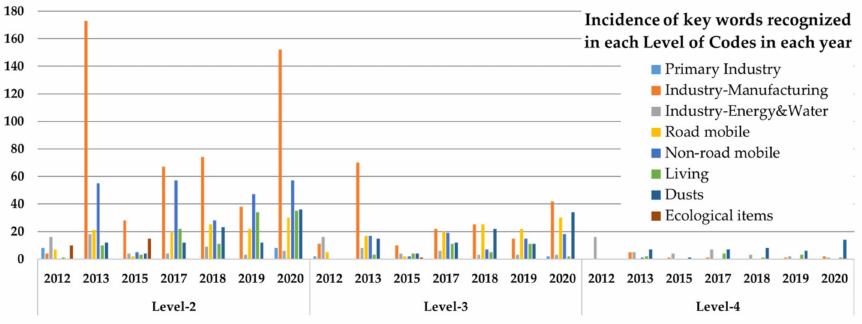
Figure 9. Evaluation of policy contents by the incidence of keywords recognized in each